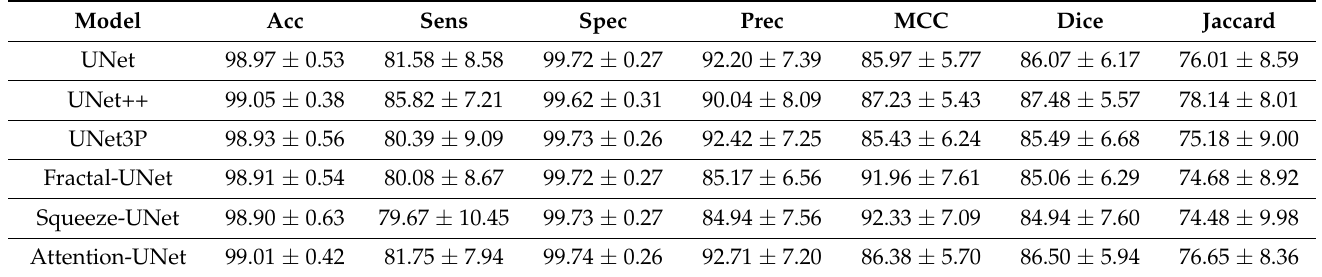
Table 4. Segmentation performance (in %) of all UNet models using CCA database